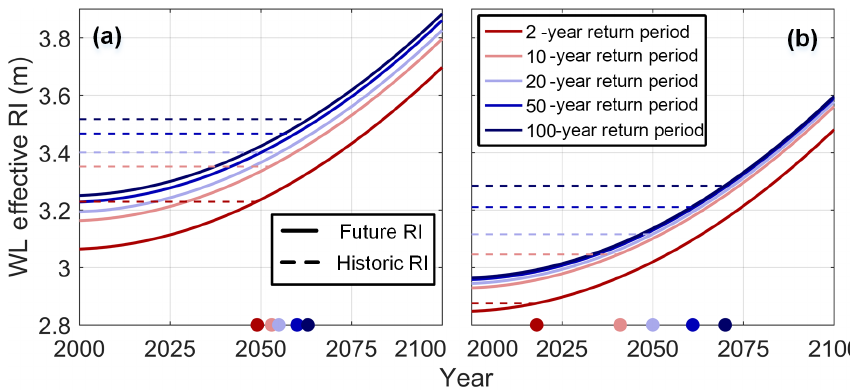
Figure 6. Tillamook (a) and Coos bay (b) effective RI WLs for the historic (dashed line) and future (solid line) periods. Shorter return periods are represented as warm colors while longer return periods are plotted as cool colors. The location of intersection between the historic and future effective RI curves is plotted on the x axis as a dot with color corresponding to return period. The x - and y -axis scaling is the same in each